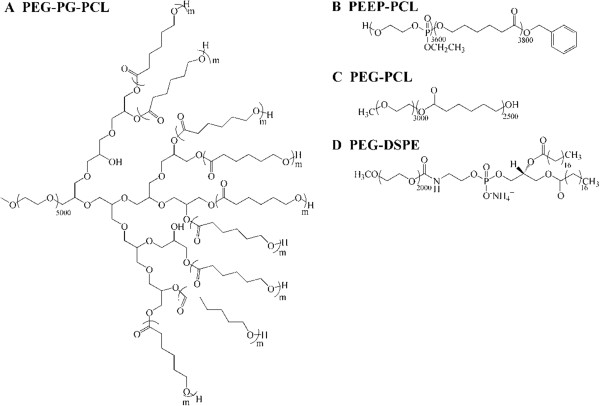
Chemical constitution of (A) PEG5000-PG300-PCL5700, (B) PEEP3600-PCL3800, (C) PEG3000-PCL2500 and (D) PEG2000-DSPE800.